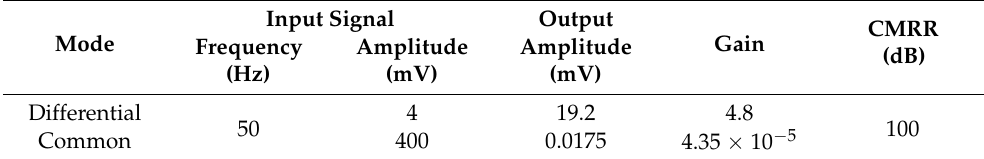
Table 2. CMRR measurement results.